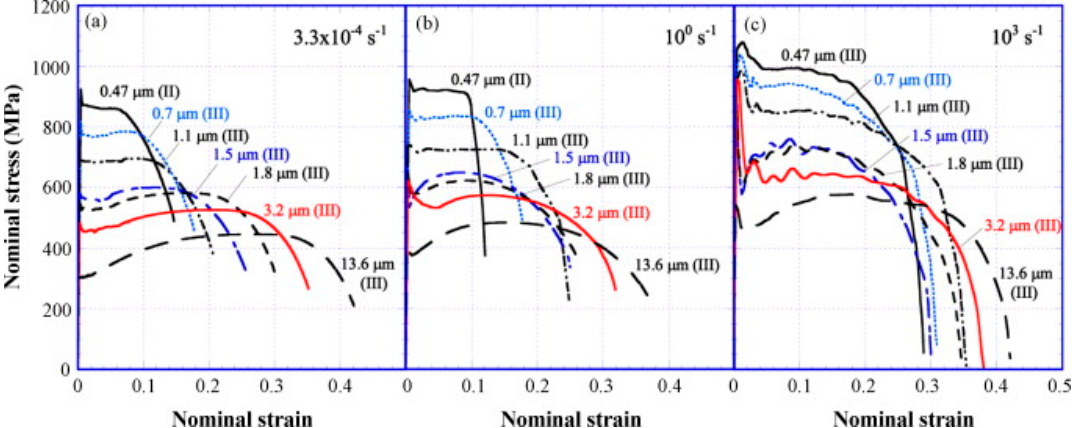
Figure 15. Nominal stress–strain curves of FC specimens obtained by tensile tests with strain rates of 3.3 × 10 − 4 s − 1 ( a ), 100 s − 1 ( b ), and 10 3 s − 1 ( c ) at 296 K [100].